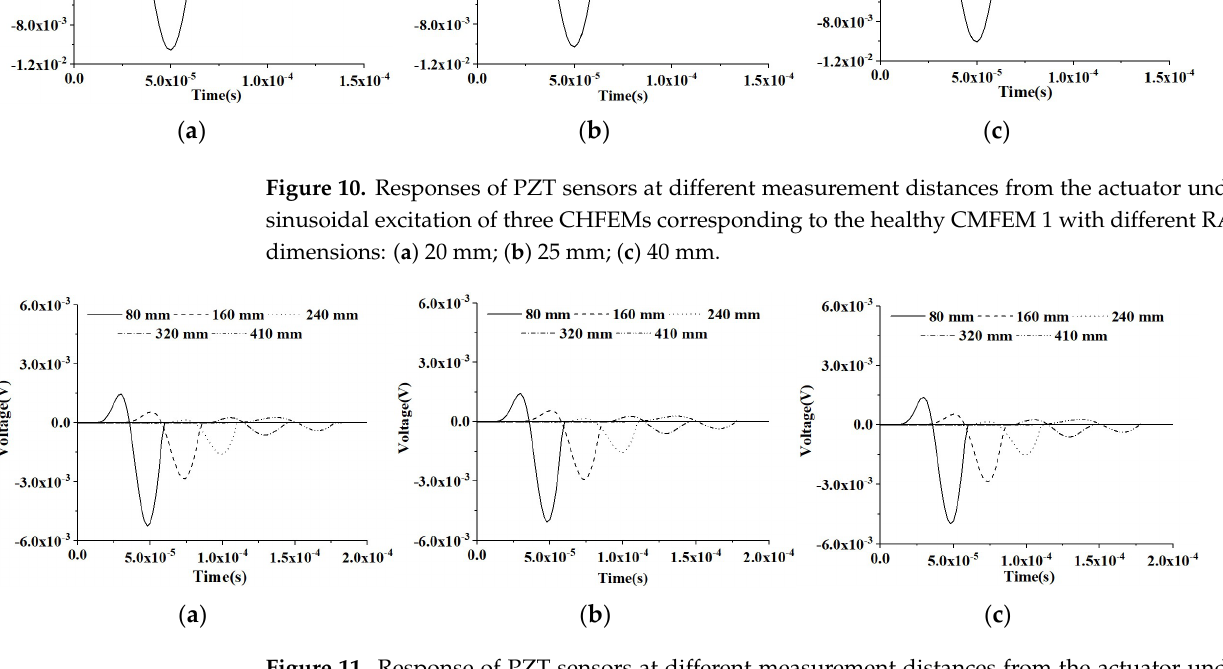
Figure 12. Response of sensors at different measurement distances from the actuator under a mod- ulated sinusoidal excitation signal for healthy CHFEMs using different RAE dimensions: ( a ) 20 mm; ( b ) 25 mm; ( c ) 40 mm.